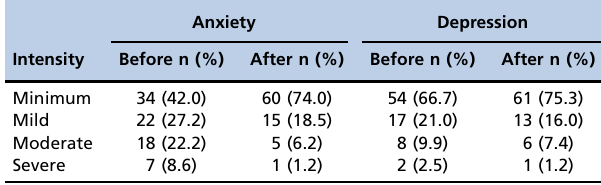
Table 5 - Concentration of anxiety and depression intensities in the patients before and after treatment with oxybutynin (n=81). Anxiety Intensity